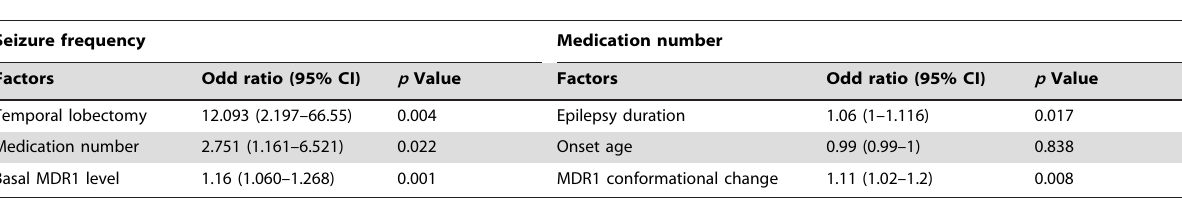
Table 4. Multiple logistic regression analysis of factors for the seizure frequency and medication number.